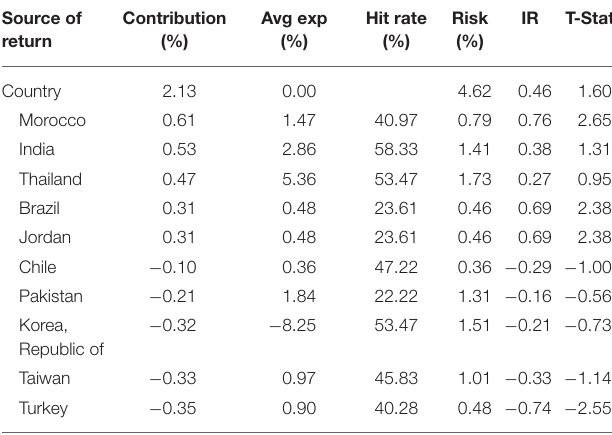
TABLE 5 | Top and Bottom 5 countries in Mean-ETL-MQ (EM)